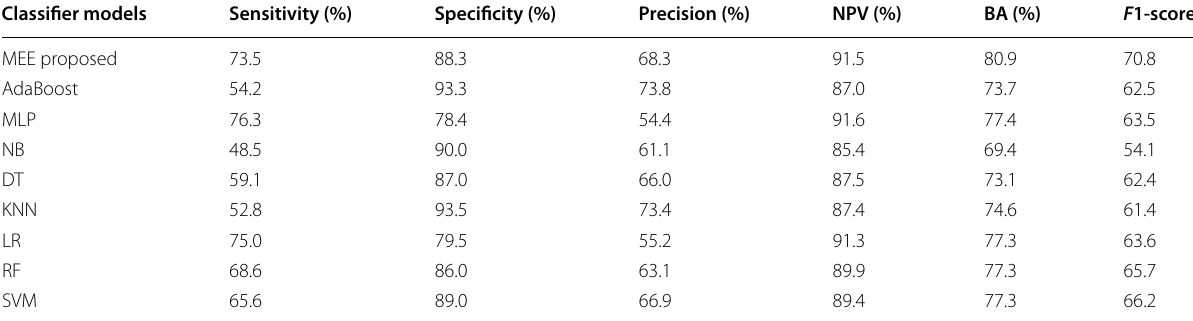
Sensitivity: ratio between the AD converter subjects correctly labeled by the algorithm and all subjects that actually converted; Specificity: ratio between the non-AD converter subjects correctly labeled by the algorithm and all subjects that have not actually converted; Precision: ratio between the correctly AD converter subjects labeled by the algorithm and the AD converters; Negative predictive value (NPV): the proportion of predicted negatives which are real negatives. It reflects the probability that a predicted negative is a true negative; Balanced accuracy (BA): the average between sensitivity and specificity; F 1-score: the harmonic average of the sensitivity and